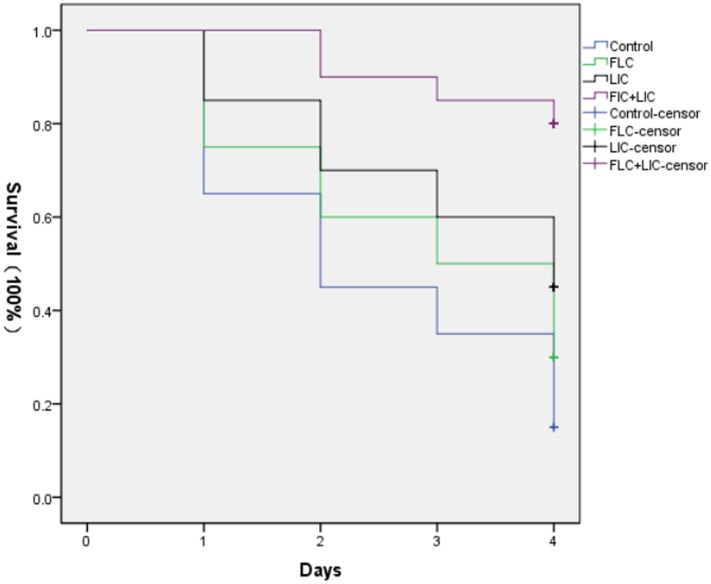
Survival curve of different treatment on G. mellonella infected with resistant C. albicans (CA10). The concentration of yeast cells was 5 × 106 cells/larva. The curves were consisted growth control (PBS) group, fluconazole (160 μg/mL) group, licofelone (80 μg/mL) group and licofelone (80 μg/mL) combined with fluconazole (160 μg/mL) group. These four curves were put in the same coordinate system to compare the survival rates. ∗P < 0.05 compared to the control, fluconazole alone and licofelone alone group. The experiment was repeated on 3 independent occasions (n = 3). Values represent the means standard deviations from three replicates.